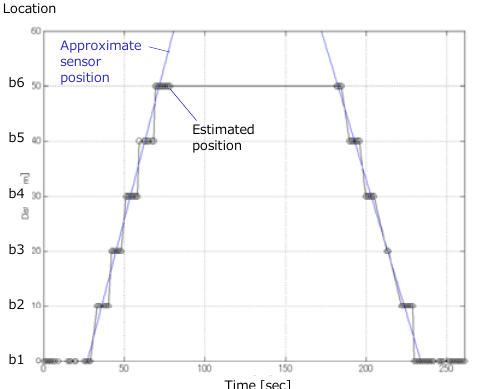
Figure 18. Estimated position using iBeacons